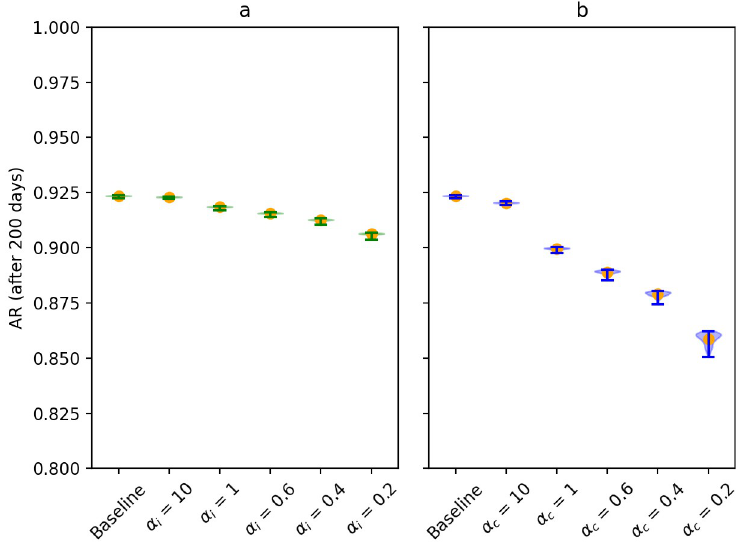
Fig 3. Violin plots for the attack rate over 200 days for scenarios investigating the infectiousness-related heterogeneity (in green, panel a) and contact-related heterogeneity (in blue, panel b). The orange dots represent the mean attack rate across the simulation runs without extinction, i.e., simulation runs in which extinction occurs ( < 20 cases) were excluded.